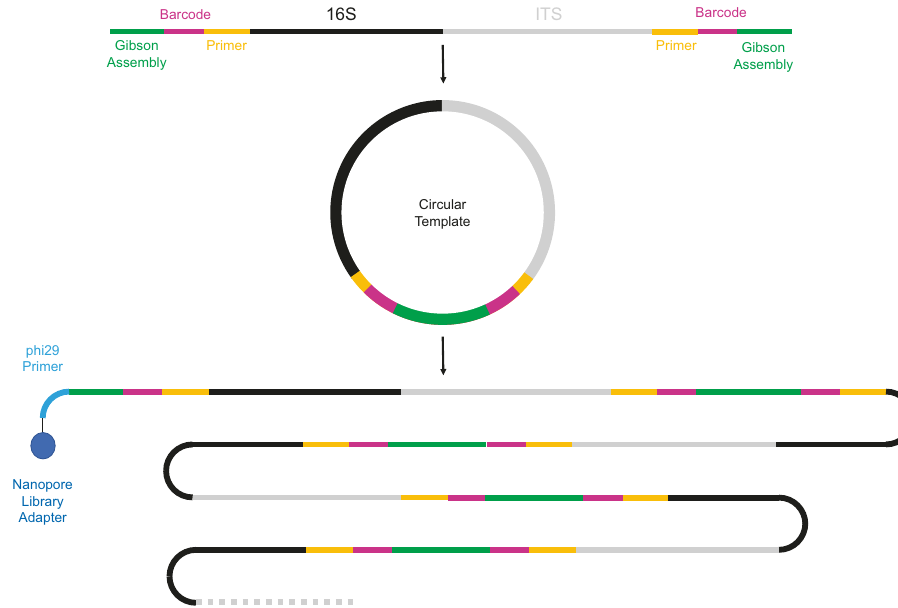
Fig. 1 Diagram illustrating RoC-ITS strategy. The 16S-ITS region is isolated using PCR. Gibson Assembly is then used to circularize the PCR products. A long single-stranded DNA product encompassing multiple iterations around the circular template is then generated using the phi29 polymerase. The linear product is fi nally modi fi ed by constructing a double-stranded A-tailed end (Nanopore Library Adapter). At this point, the product is ready for normal library construction using a Nanopore DNA library